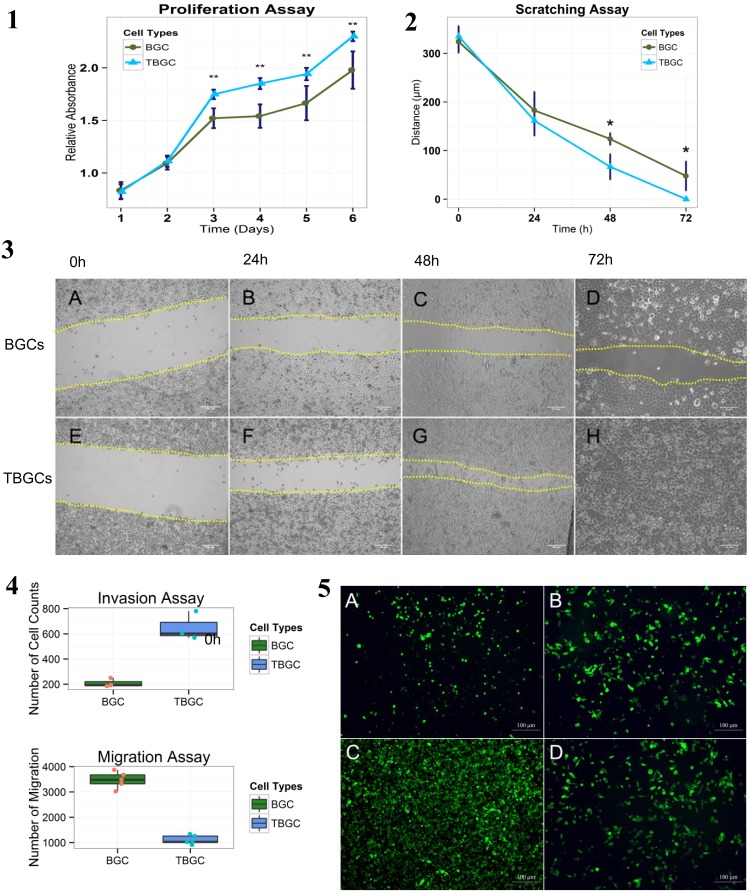
Proliferation, invasion, and mobility of TBGCs.
Figure 2.1.Line plot of the proliferation assay. Vertical lines denote standard differences. **p<0.01.
Figure 2

.2. Line plot of the scratching assay. Vertical lines denote standard differences. **p<0.01.
Figure 2

.3. Scratching assay of BGC-823 cells (above) and TBGCs (below) under a phase-contrast microscope. (A–D, E–H) Time from initial to 72 hours.
Figure 2

.4. Box plot of the invasive and migration assays. Differences between BGC-823 cells and TGBCs are significant (p<0.01).
Figure 2

.5. The top 2 photos show the results of the invasive modified transwell assay with Matrigel. Representative images of the transwell invasion assays for (A) BGC and (B) TBGC. Cells invading the underside of the transwell insert are shown. The bottom 2 photos are representative images of the transwell migration assays for (C) BGC and (D) TBGC. Cells migrating to the underside of the transwell insert are shown.